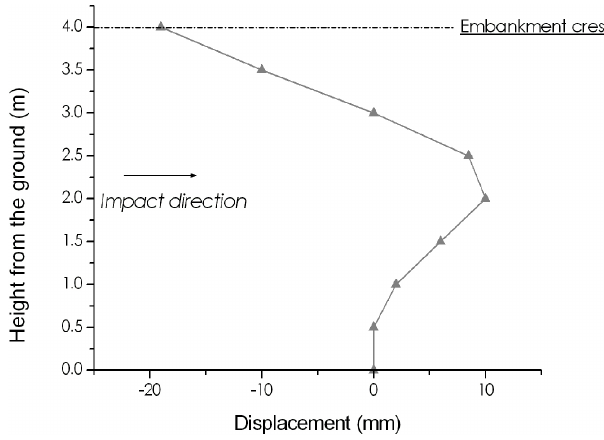
Figure 11. Displacements measured with the inclinometer within the levee, 0.50m from the kernel–levee interface.